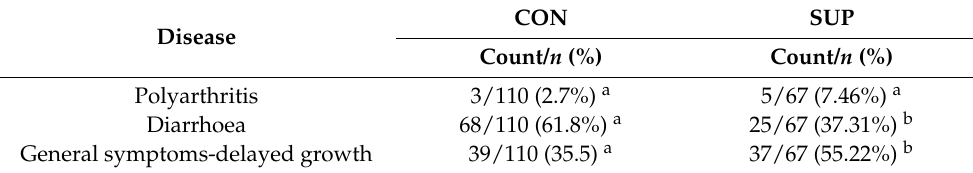
Table 8. Disease distribution in the CON and SUP groups. Data are count/n; percentages are shown in brackets. a,b : different letters in the same row mean significant differences ( p < 0.05). CON: control group; SUP: colostrum supplemented group. Comparisons between groups were made by using Pearson’s Chi squared test. General symptoms refer to nonspecific symptoms that do not point to any specific disease. Delayed growth indicates narrow animals or lighter than their